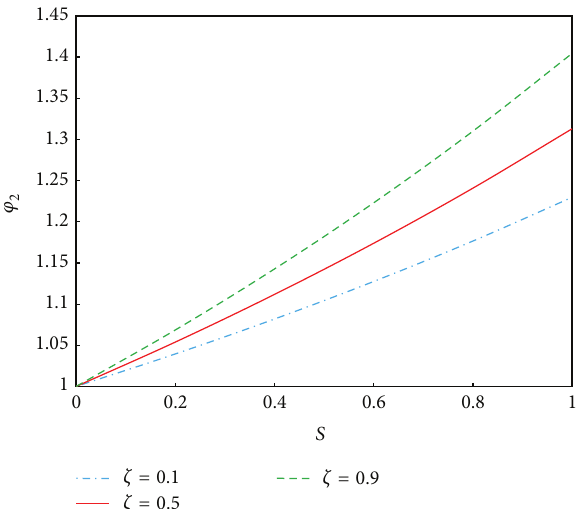
Figure 5: Relationship between ratio 𝜑 2 and dimensionless param- eter 𝑠 for different axial compression ratio 𝜁